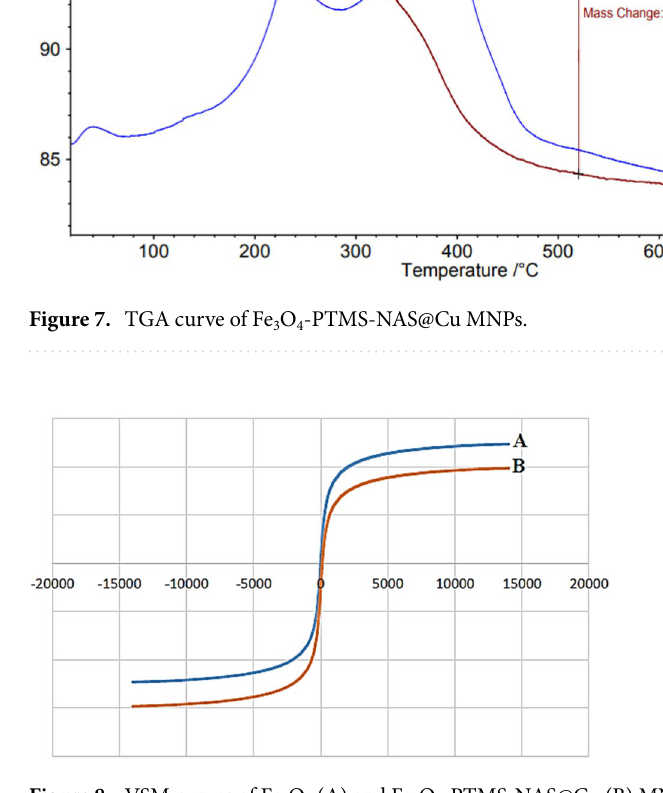
Figure 8. VSM curves of Fe 3 O 4 (A) and Fe 3 O 4 -PTMS-NAS@Cu (B) MNPs.